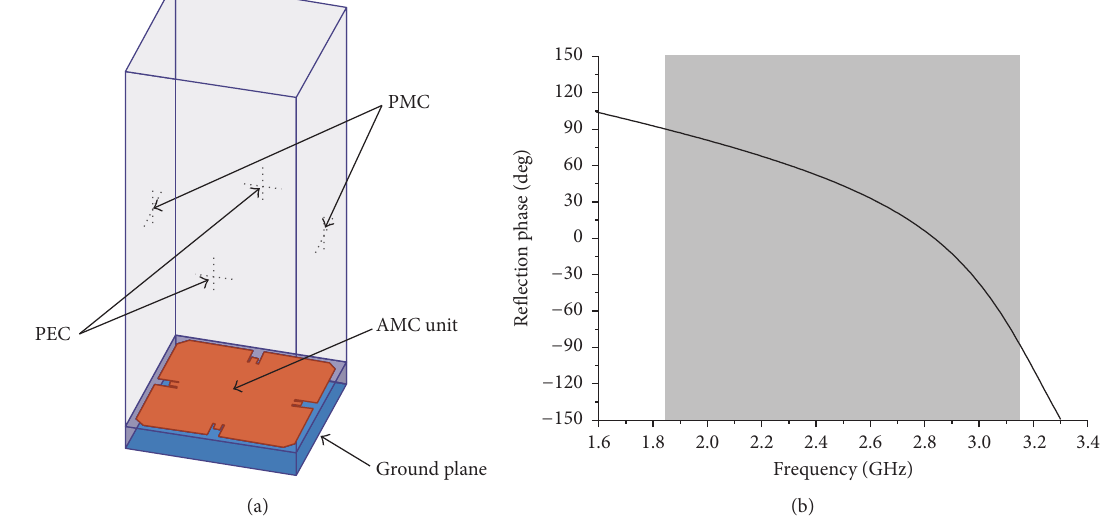
Figure 2: (a) Simulation model of AMC unit. (b) Simulated reflection phase of the proposed AMC unit.